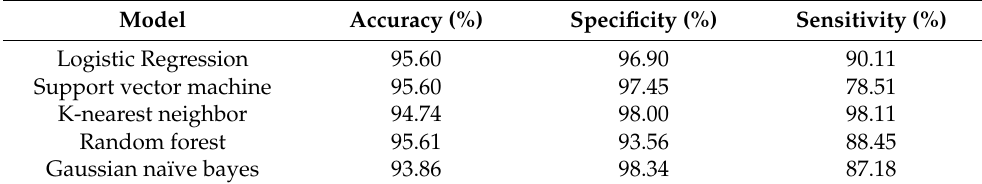
Table 3. Performance evaluation of classification models with five fittest selected features.